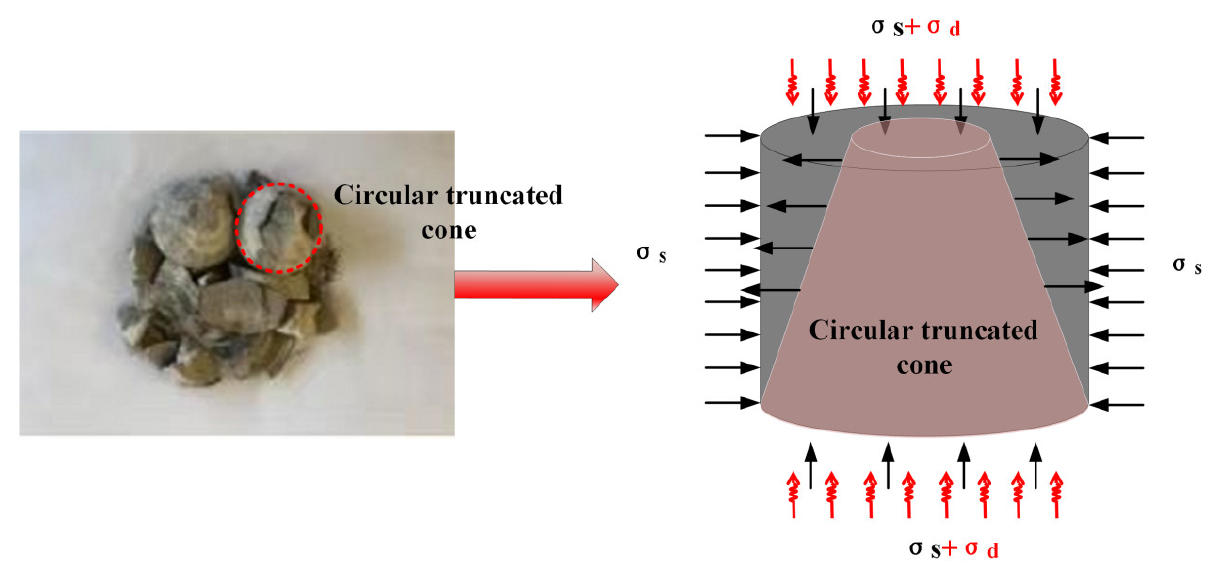
Figure 11. Schematic diagram of circular-platform fragmentation.